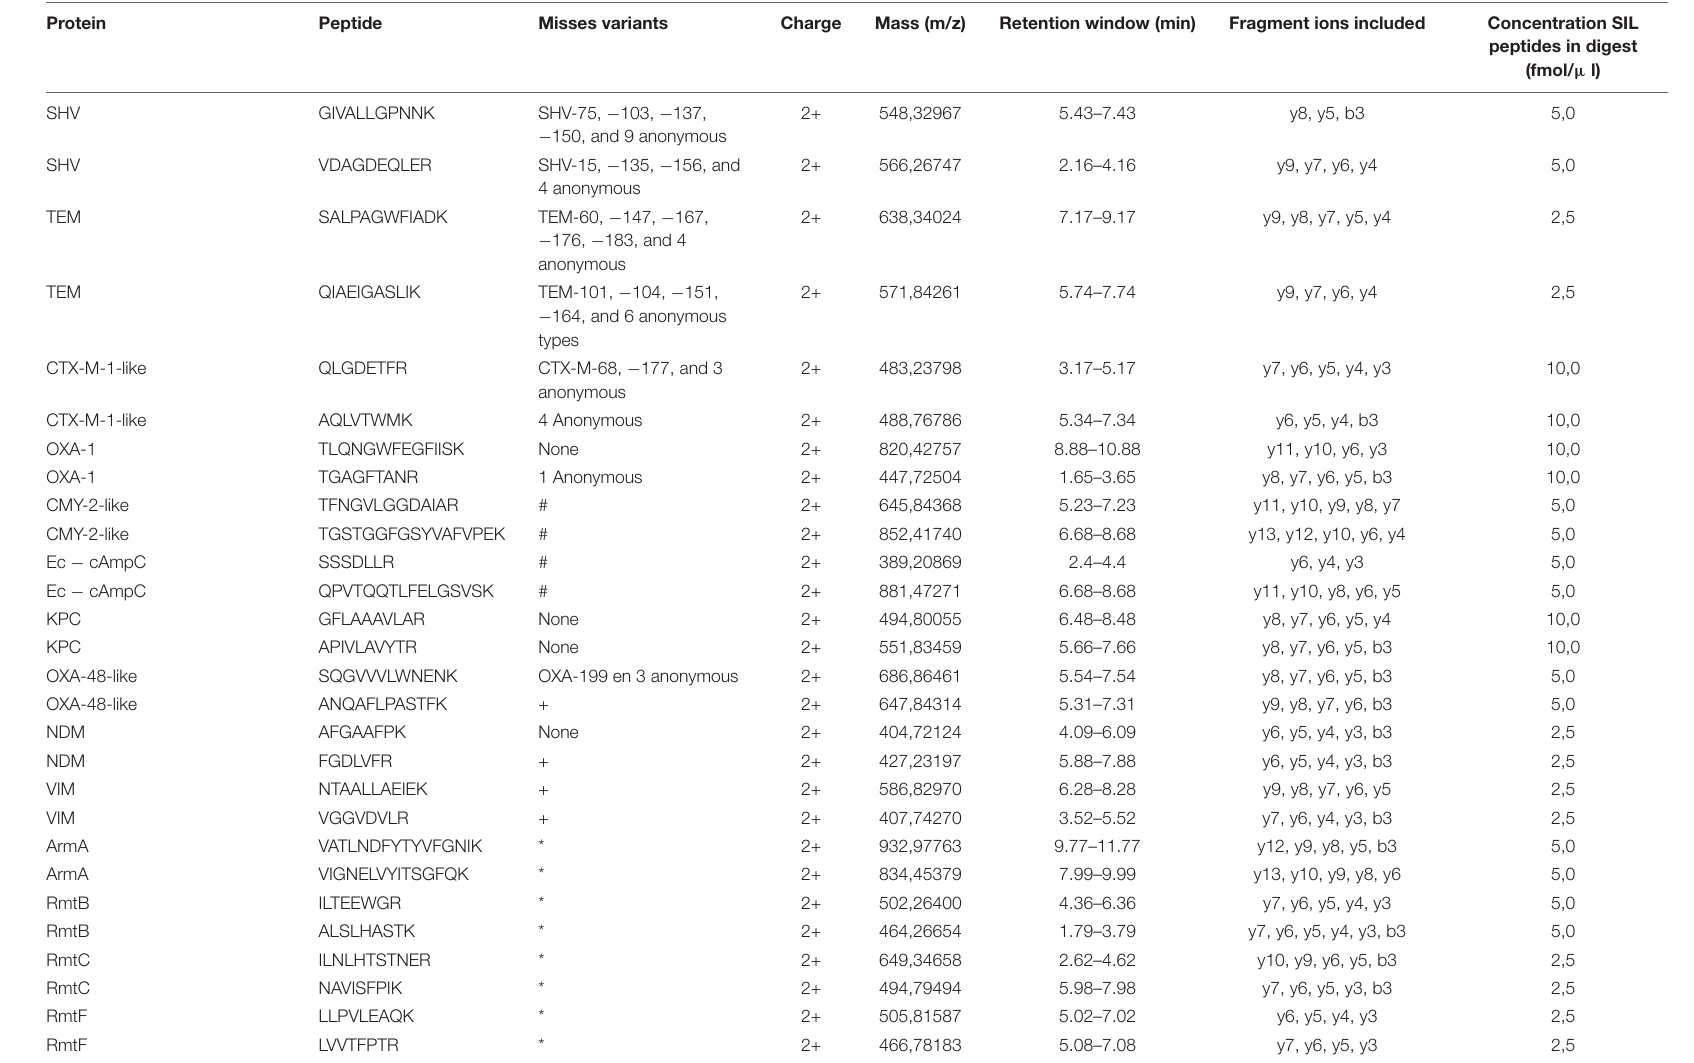
TABLE 2 | Selected target peptides included in the final panel for the detection of 27 resistance mechanisms and three internal quality control proteins. Protein Peptide Misses variants Charge Mass (m/z) Retention window (min) Fragment ions included Concentration SIL